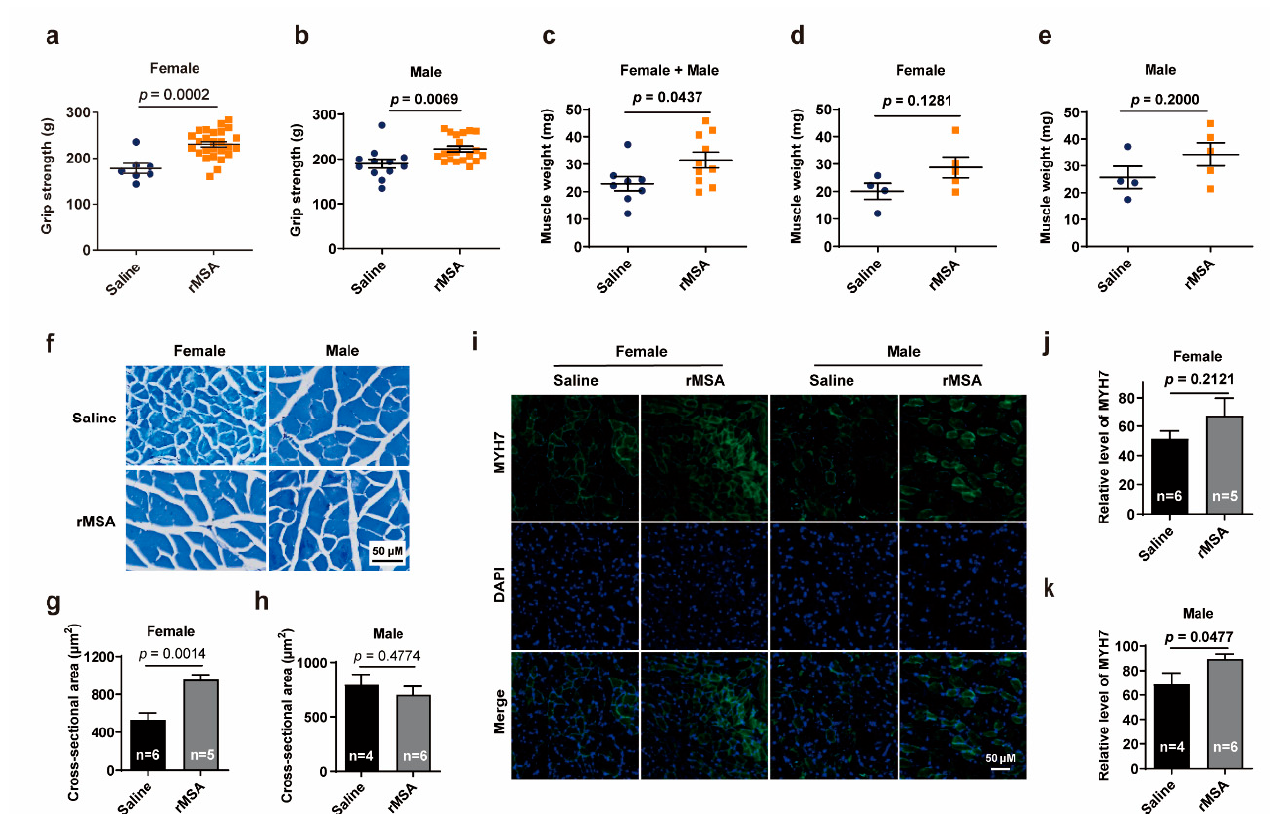
Figure 2. The effects of rMSA on the function of skeletal muscles in mice ( a , b ) The grip strength of female ( a ) and male ( b ) mice. ( c – e ) The muscle weight of female + male ( c ), female ( d ), and male ( e ) mice. ( f ) The Toluidine Blue O staining of gastrocnemius muscle. Scale bar, 50 µ m. ( g , h ) The cross-sectional area of myofibers in female ( g ) and male ( h ) mice. ( i ) The immunofluorescence staining for MYH7 (green) and DAPI (blue) in mice. Scale bar, 50 µ m. ( j , k ) The relative level of MYH7 in female ( j ) and male ( k ) mice. Mice were treated with rMSA 1.5 mg per gram of body weight or isometric saline every 3 weeks for 8 months. All graphs represent mean with SEM, with p values calculated by the two-tail t test. n, number of mice used for each analysis.